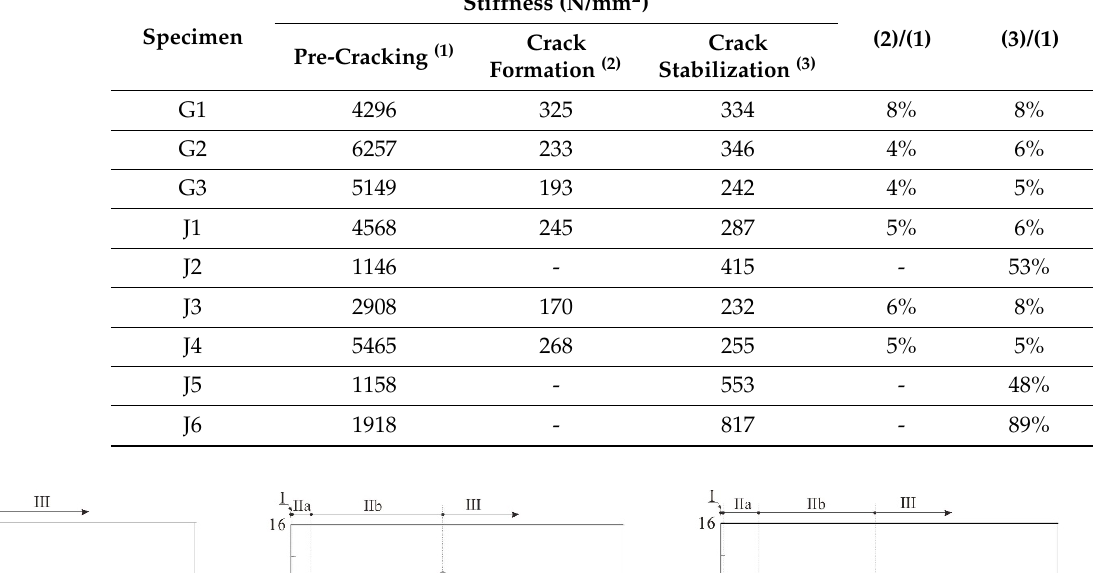
Table 7. Stiffness of the specimens at pre-cracking, crack formation, and crack stabilization stages.